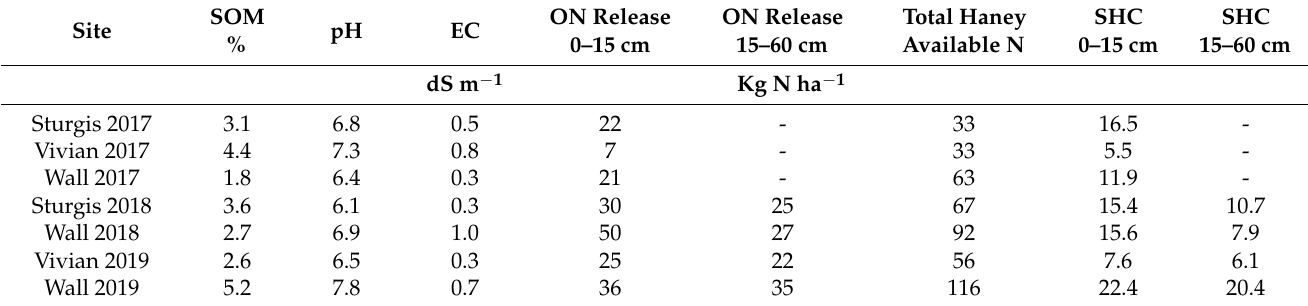
Table 1. Initial values for soil organic matter (SOM), pH, electrical conductivity (EC), organic nitrogen released (ON release), total Haney available nitrogen (N), and soil health calculations (SHC) using Haney Soil Test